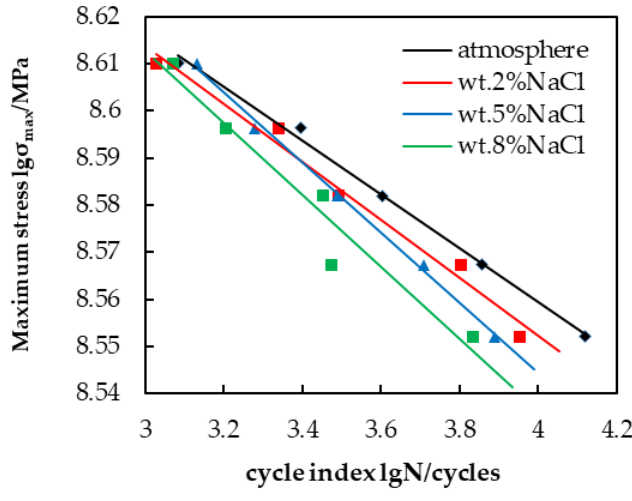
Figure 10. Fitting of stress fatigue life curves (S-N curves) for Q235 galvanized steel in four environ- ments.